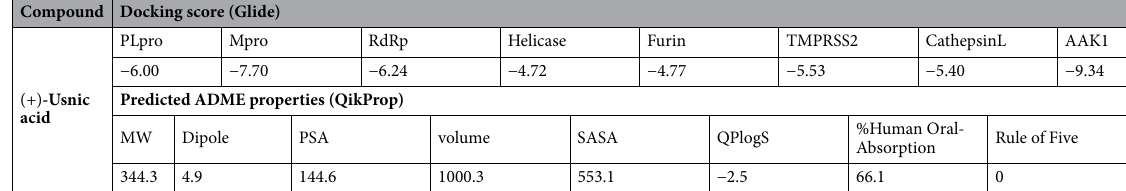
Table 2. The calculated molecular property of the selected compound, (+)-usnic acid. The molecular property includes docking scores of protein targets and predicted ADME properties (dipole, PSA, volume, SASA, QplogS,